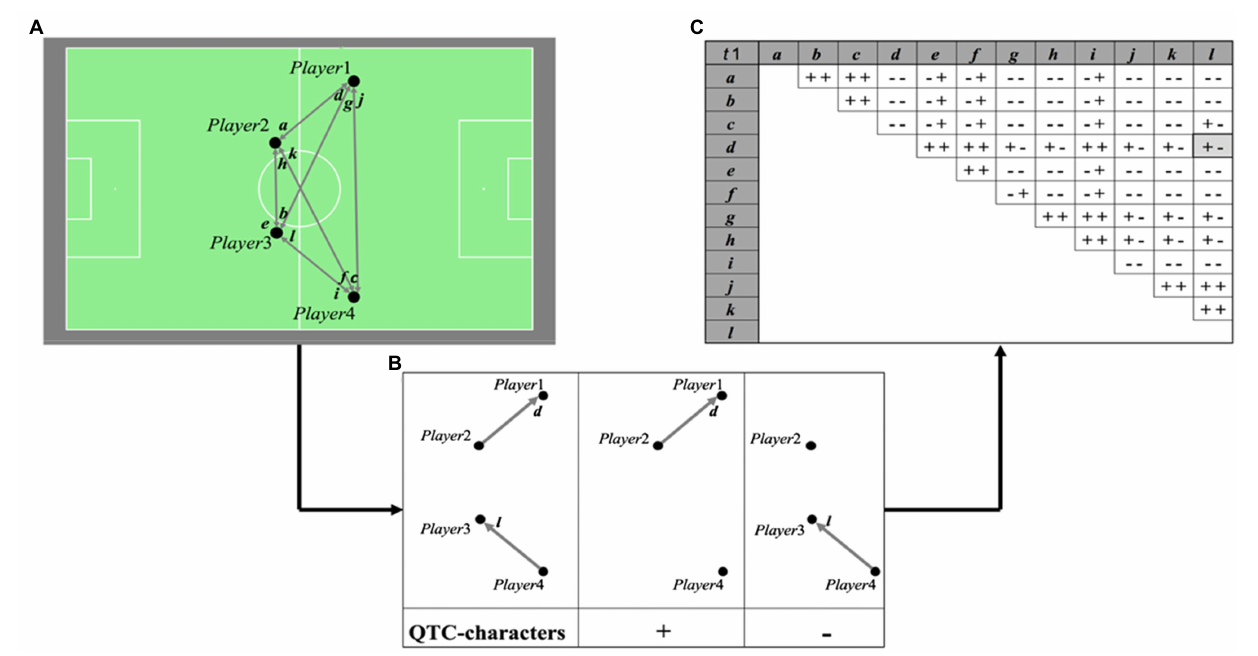
FIGURE 1 | A formation of four players (POs) on a football field at t1 and the vectors between them (A) . The construction of the Qualitative Trajectory Calculus (QTCs)-relations between two vectors d and l , consisting of the QTC S -relation of vector d with respect to the starting point of vector l and of the QTC S -relation of vector l with respect to the starting point of vector d . If the vector moves away from the starting point of the other vector, the QTC S -relation is denoted by “+,” if the movement is toward the marker, the QTC S -relation is denoted by “ − .” If the movement is neither away nor toward the marker (thus perpendicular to the connecting line between the two starting points), the QTC S -relation is denoted by “0” (B) . The QTC S -matrix describing the full formation of the four players, including all relations between all the vectors ( C ; Reproduced from Beernaerts et al., 2018, with permission from